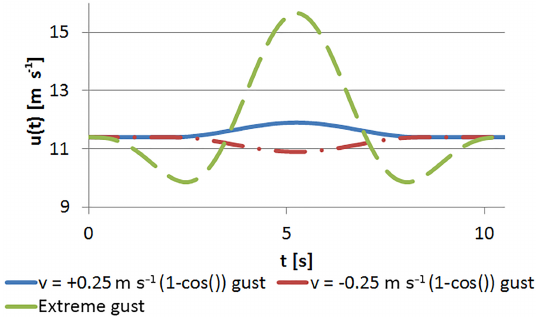
Figure 2. Inflow velocity with dependence on physical time t . soidal